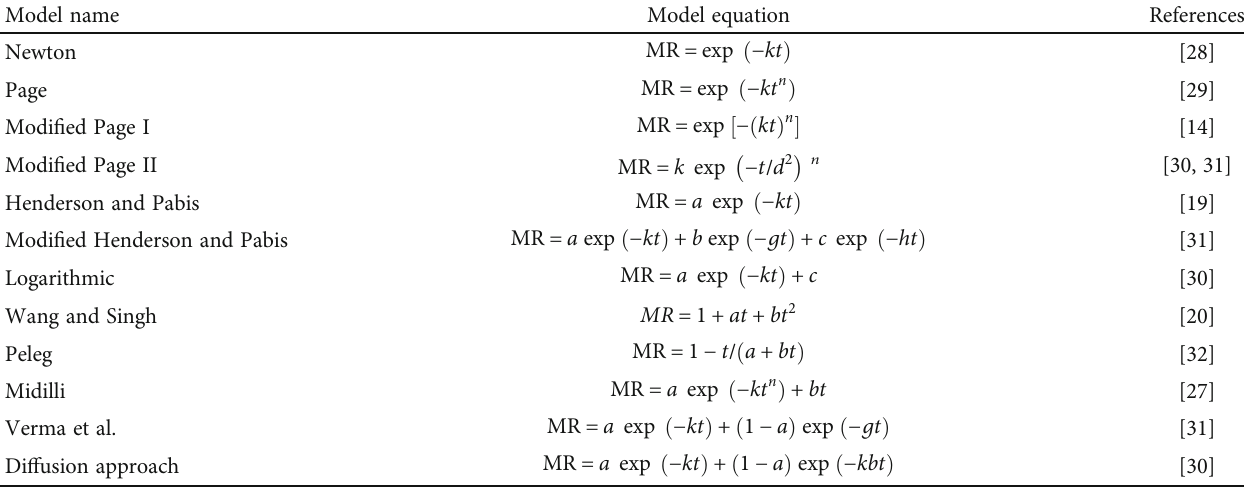
Table 1: Mathematical models for describing thin layer drying